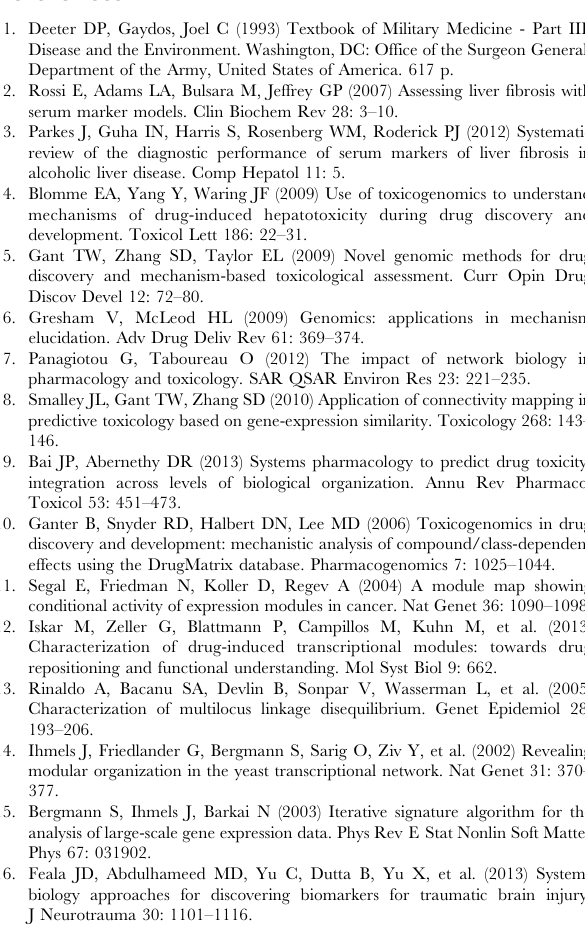
Table S3 Gene module map containing 78 rows of modules and 34 columns defined by injury indicator or structure activity classes where each entry of the matrix corresponds to the module activation. Table S4 Module cluster activation patterns before averaging over the module clusters. Table S5 General liver injury gene signature